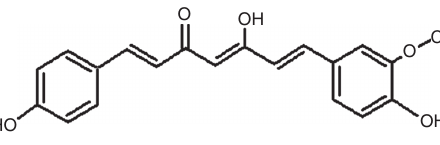
Figure 2: Structure of demethoxycurcumin.